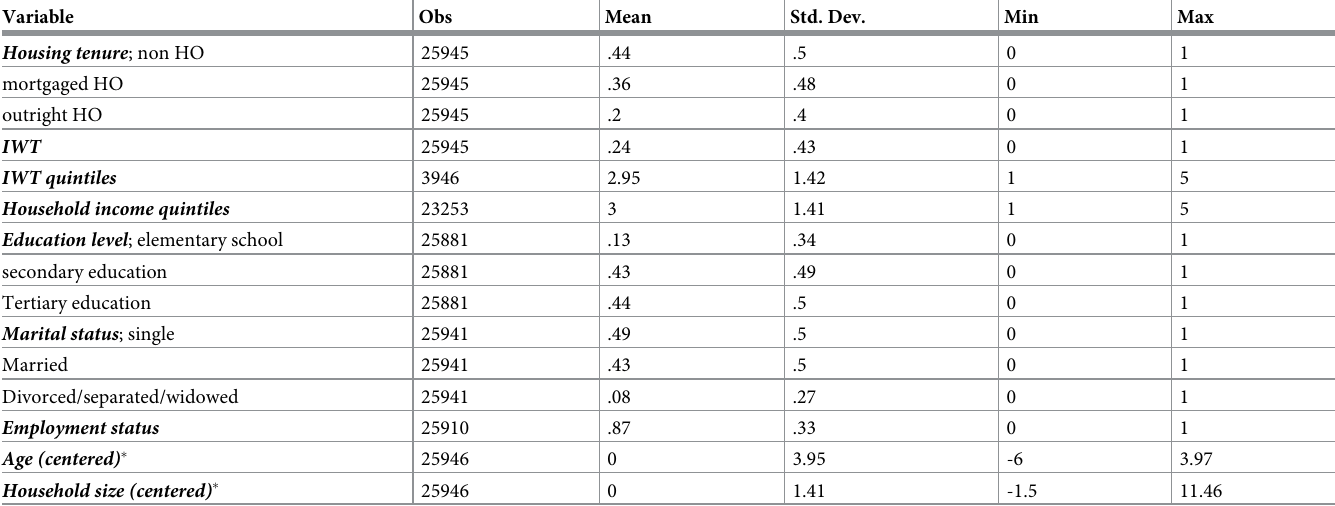
Table 1. Descriptive statistics of the sample household level